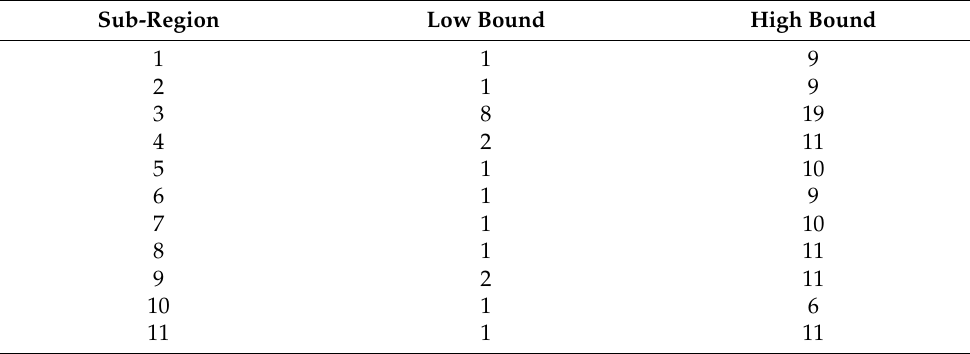
Table 7. Setting of vehicle configuration number for each station in OptQuest